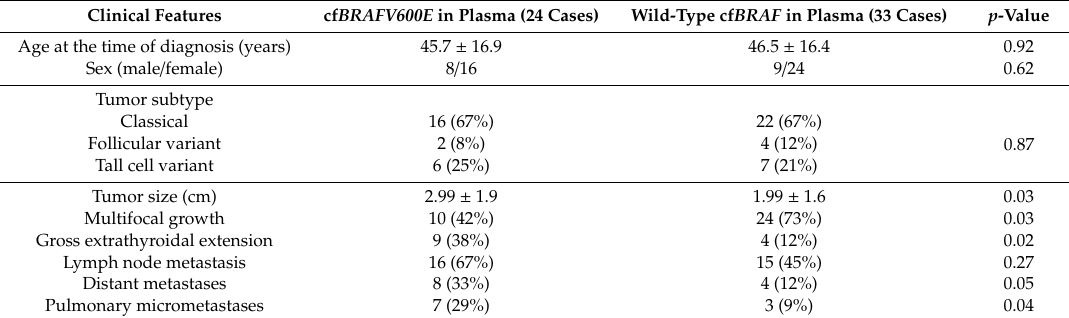
Table 1. Clinicopathological features of the BRAFV600 -positive papillary thyroid carcinomas.